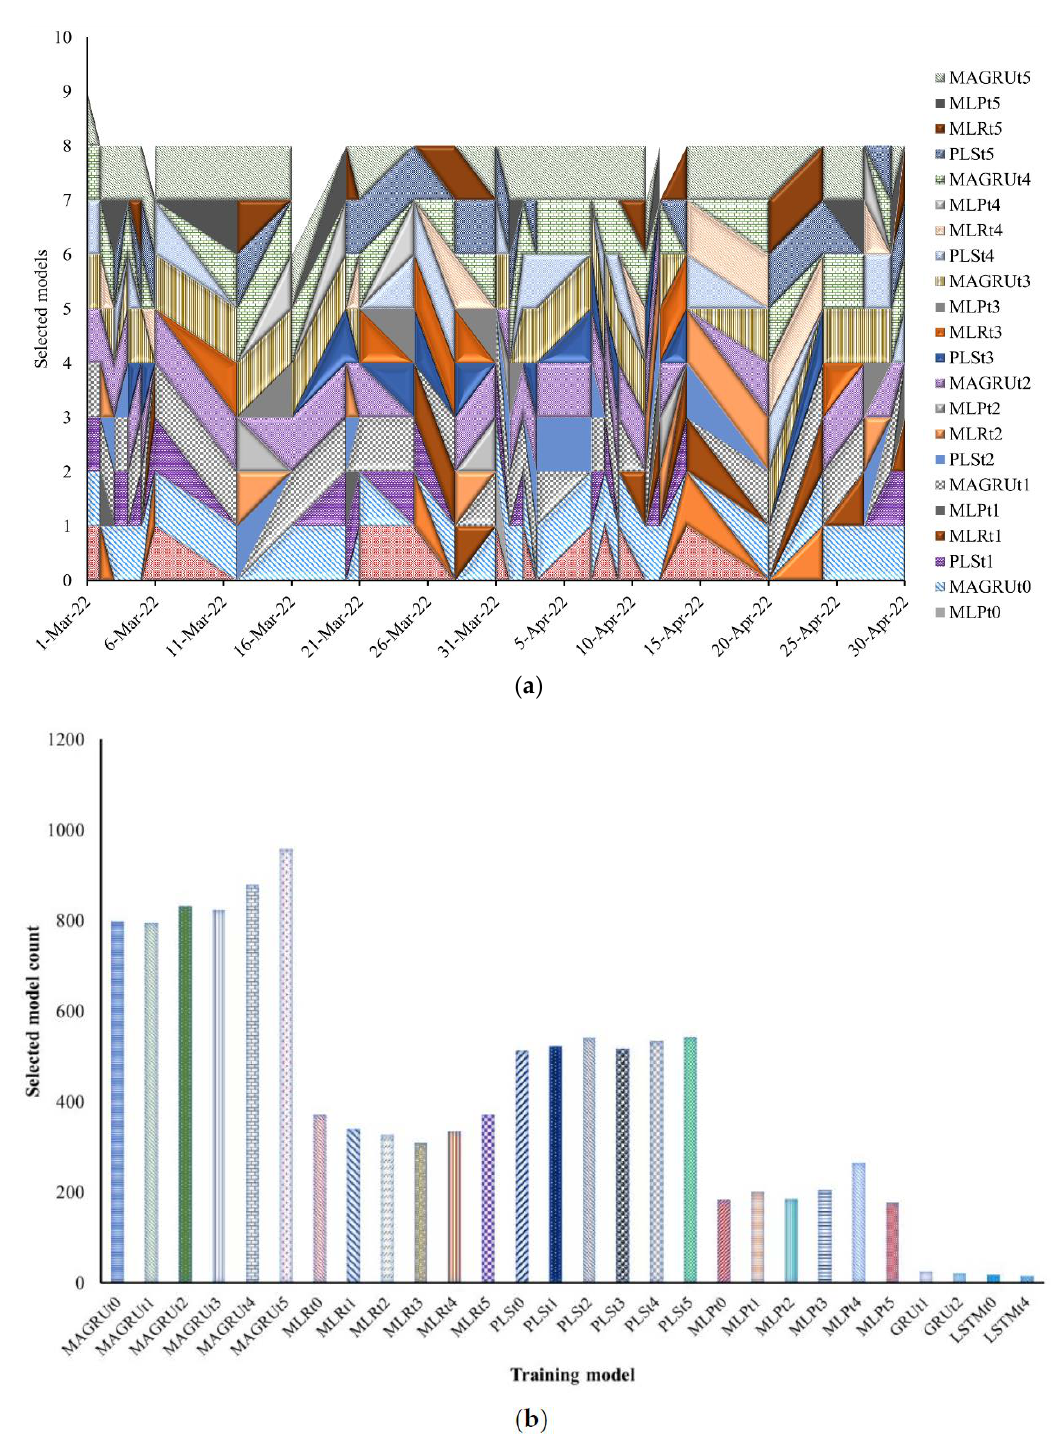
Figure 9. Results of the ( a ) selection of different training models in time series ( b ) number of counts of selected models in training